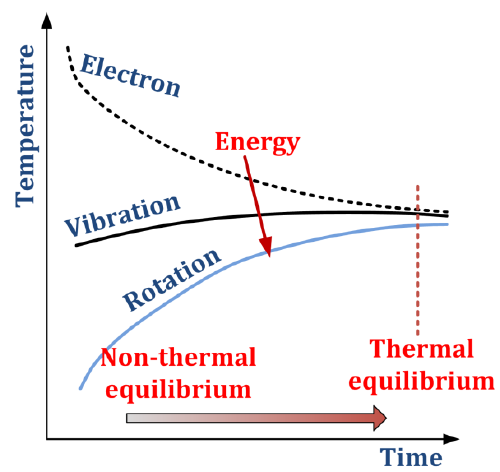
Figure 8. Energy relaxation in spark-discharge plasma. The picture was drawn by the authors using the data from [136].